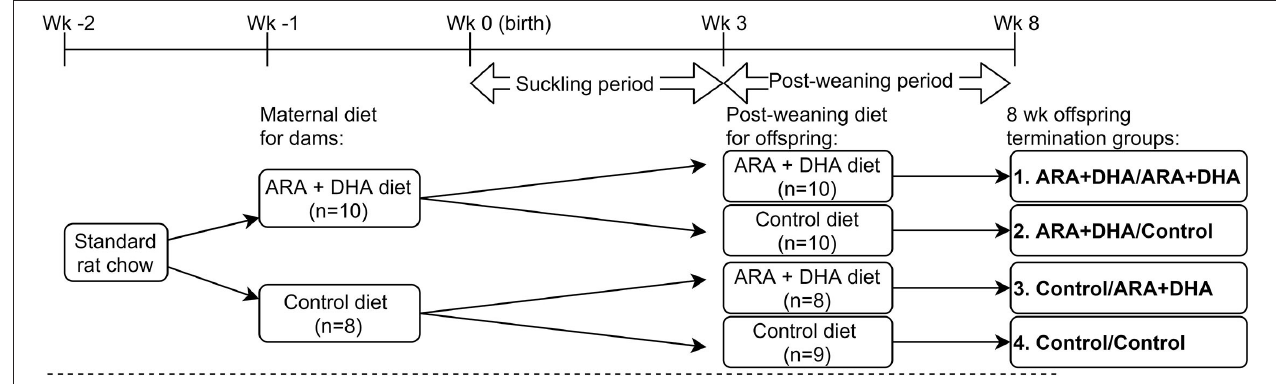
FIGURE 1 | Animal study design. Pregnant Brown Norway dams were assigned to either arachidonic acid + docosahexaenoic acid (ARA + DHA) supplemented maternal diet ( n = 10) or control diet ( n = 8) 5–7 d before parturition and continued the same diet throughout the suckling period (3 weeks). Male and female offspring were culled between the same diet group of dams to get an approximate sex ratio match between the 4 diet groups. Offspring breastfed to their dam during the suckling period. At the end of the suckling period, offspring from each dam consumed either ARA + DHA post-weaning diet or control post-weaning diet until 8 weeks (post-weaning period) from birth. Dams were killed at the end of the suckling period and offspring at the end of the post-weaning period. The animal experiments were conducted in serial blocks to achieve n = 8 offspring per diet